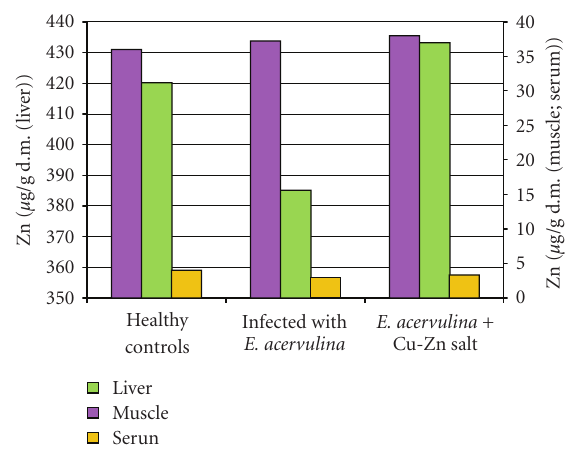
Figure 3: Zn level in broiler